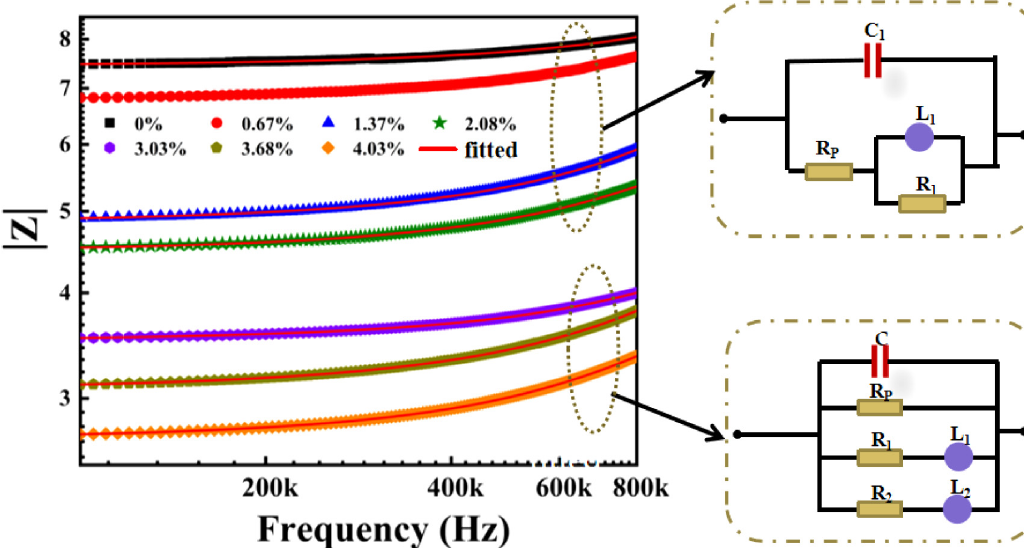
Fig. 6. Impedance module spectra of CFS/AgNWs composites with different content of